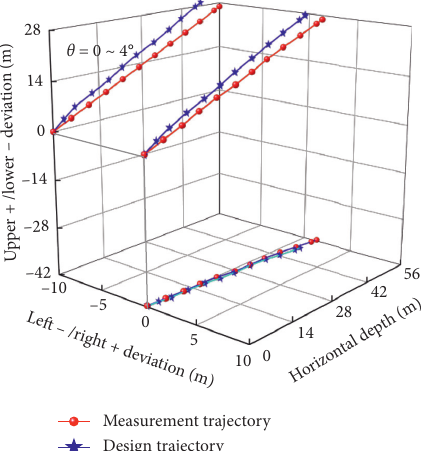
Figure 5: Borehole offset when the angle of encountered layer is less than the critical